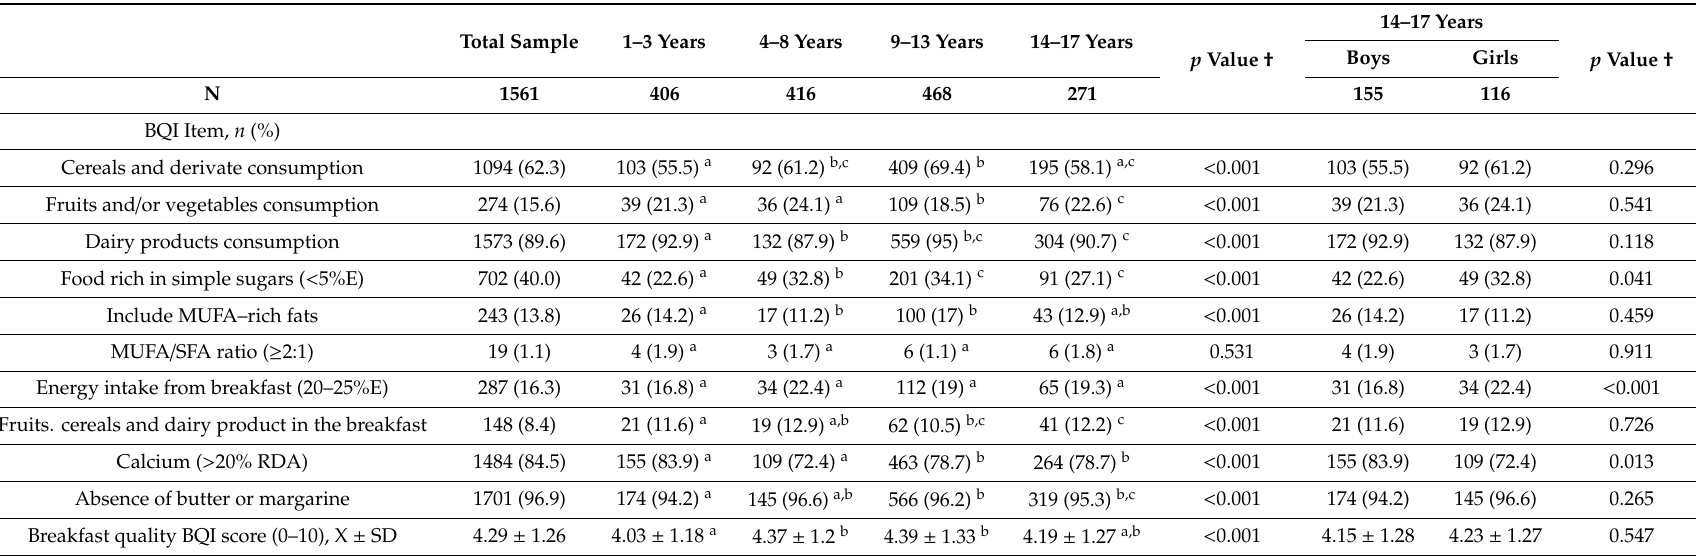
Table 3. Breakfast Quality Index (BQI) components and number of children meeting the criteria ( n , %) by age